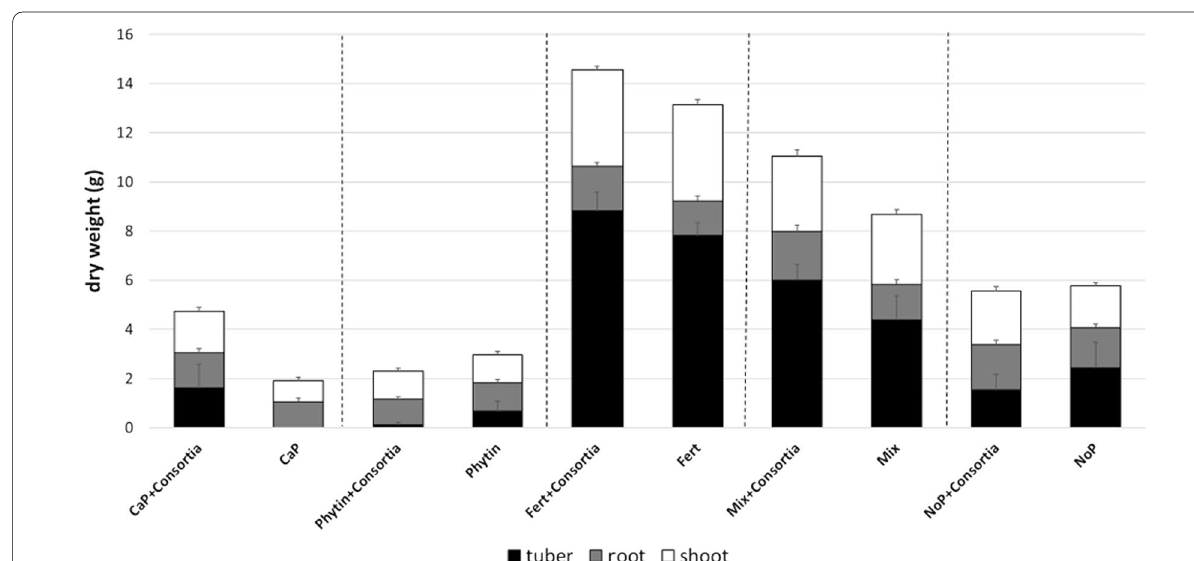
Fig. 2 Mean biomass (oven-dry weight) for potatoes grown in a greenhouse under various P sources, both with and without the inoculation of a consortia of P-solubilizing bacteria. Potato plant biomass is divided into three components (shoot, root, and tubers). Error bars represent the standard error of the mean for each plant